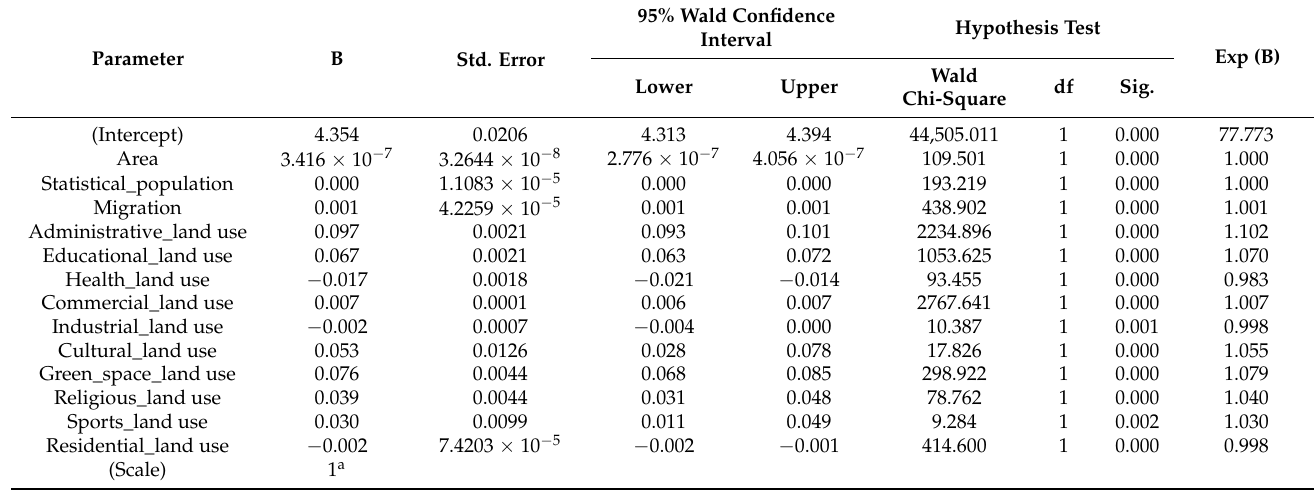
Table 2. Poisson regression model for pick-up locations.